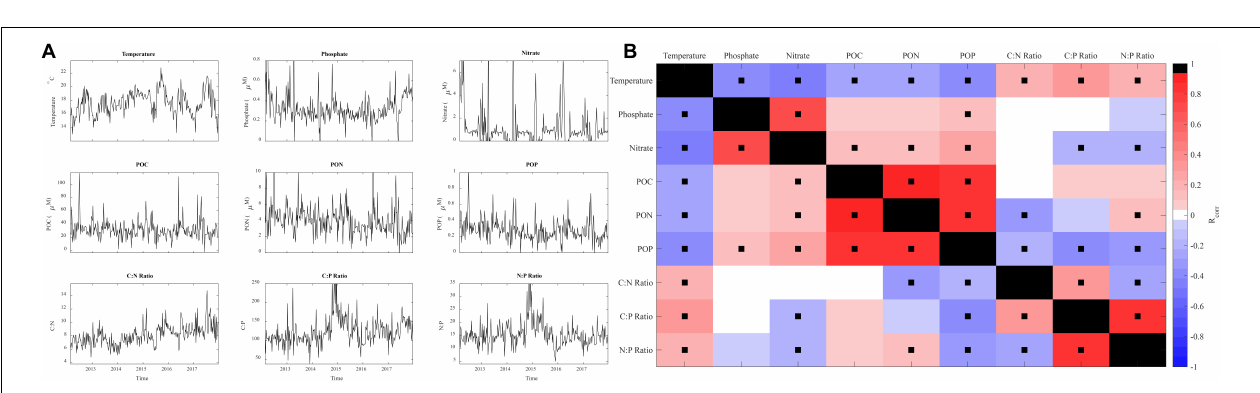
FIGURE 3 | Seasonally detrended values and correlations in environmental conditions, macronutrients concentrations, POM concentrations, and stoichiometric ratios. (A) Detrended seasonal data over time for each factor. Statistical trends quantified using a Mann-Kendal analysis ( p < 0.05). (B) Pearson correlation coefficient for each pair of factors. Redder squares signify a strong positive correlation between the two variables, while blue squares signify a strong negative correlation between the two variables. Large black squares represent a correlation of 1. The small black squares indicate that the correlation is statistically significant.